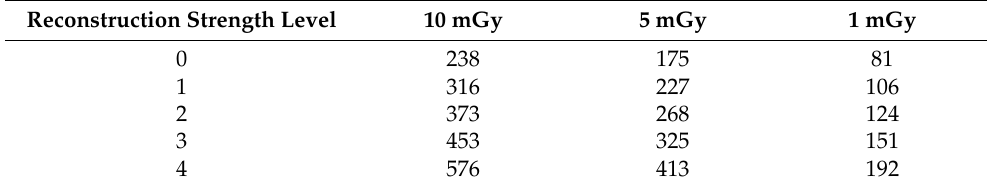
Table 8. Detectability index values when varying the IR level and the CTDI vol for the PCCT scanner for virtual monoenergetic